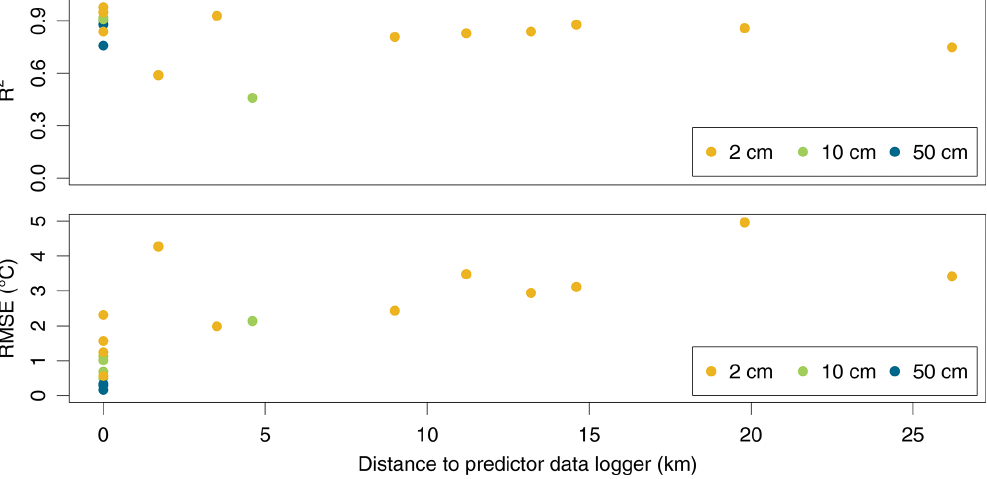
Figure B2. Coefficient of determination ( R 2 ) and root mean square error (RMSE) of each gap-filled ground temperature time series with respect to the absolute distance (in kilometres) to the data logger (predictor) used for the gap-filling procedure. Please refer to Sect. 3.3 and the supplementary file “information_sheet_data_gap-filling.ods” (Sect. 6) for more details regarding the gap-filling procedure.